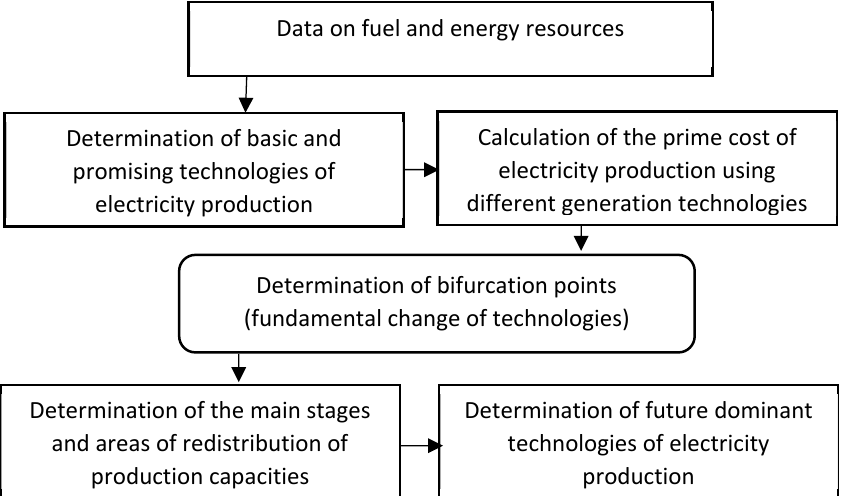
Fig. 2 : Model for determination of the future dominant technologies of electricity